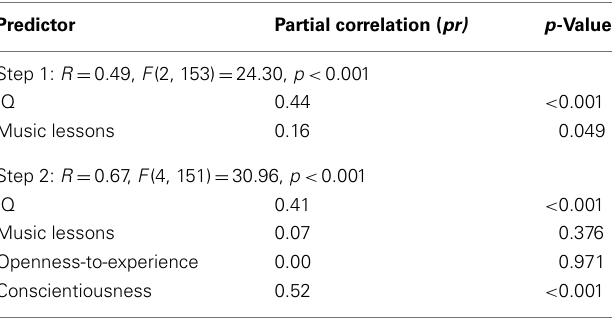
Table 5 | Results from hierarchical multiple regression in study 2